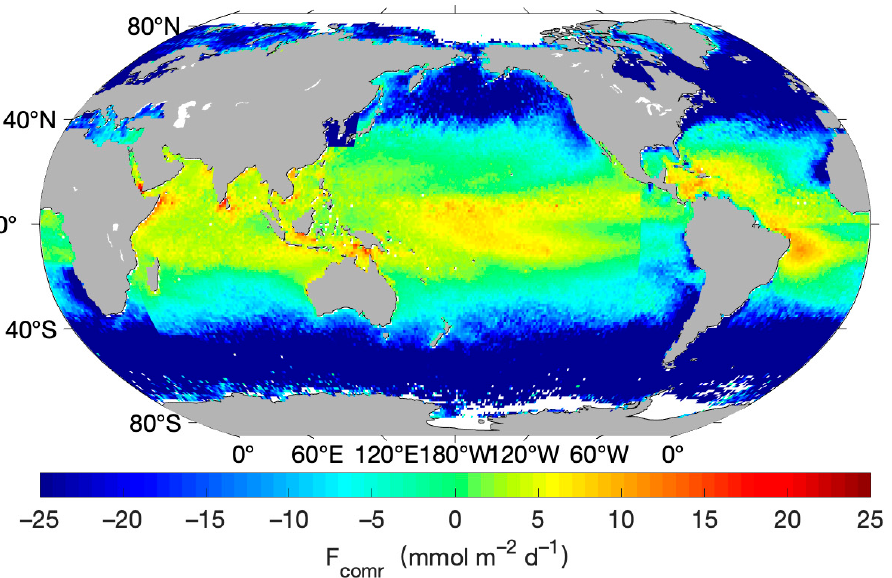
Figure 15. Distribution of CO 2 sources and sinks in the global ocean from September 2020 to August 2021.